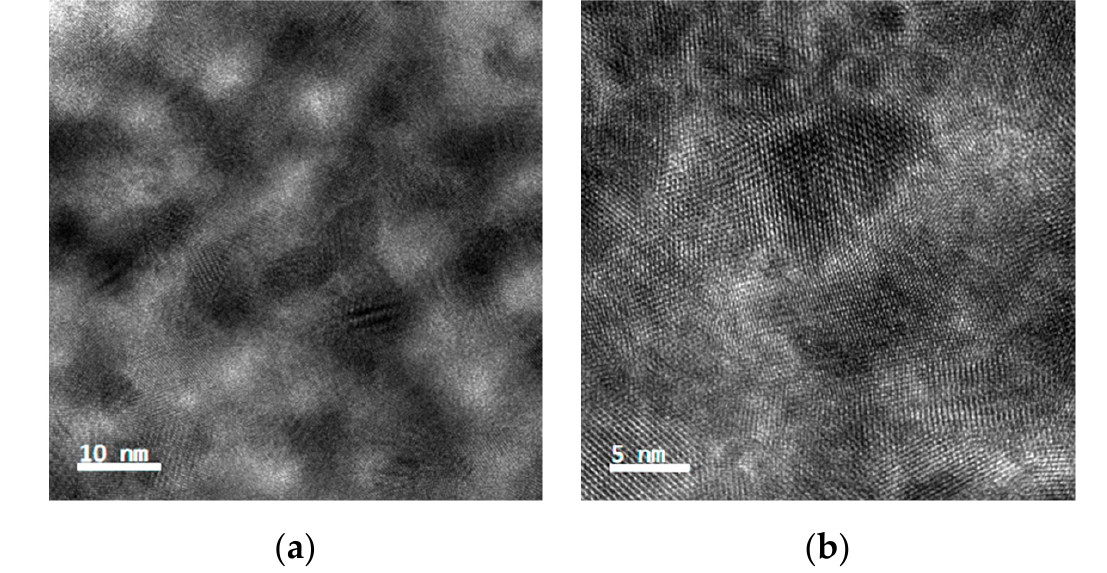
Figure 4. FIB-TEM images of PbS quantum dot films treated with Na 2 S at different scales. ( a ) 10 nm, ( b ) 5 nm.